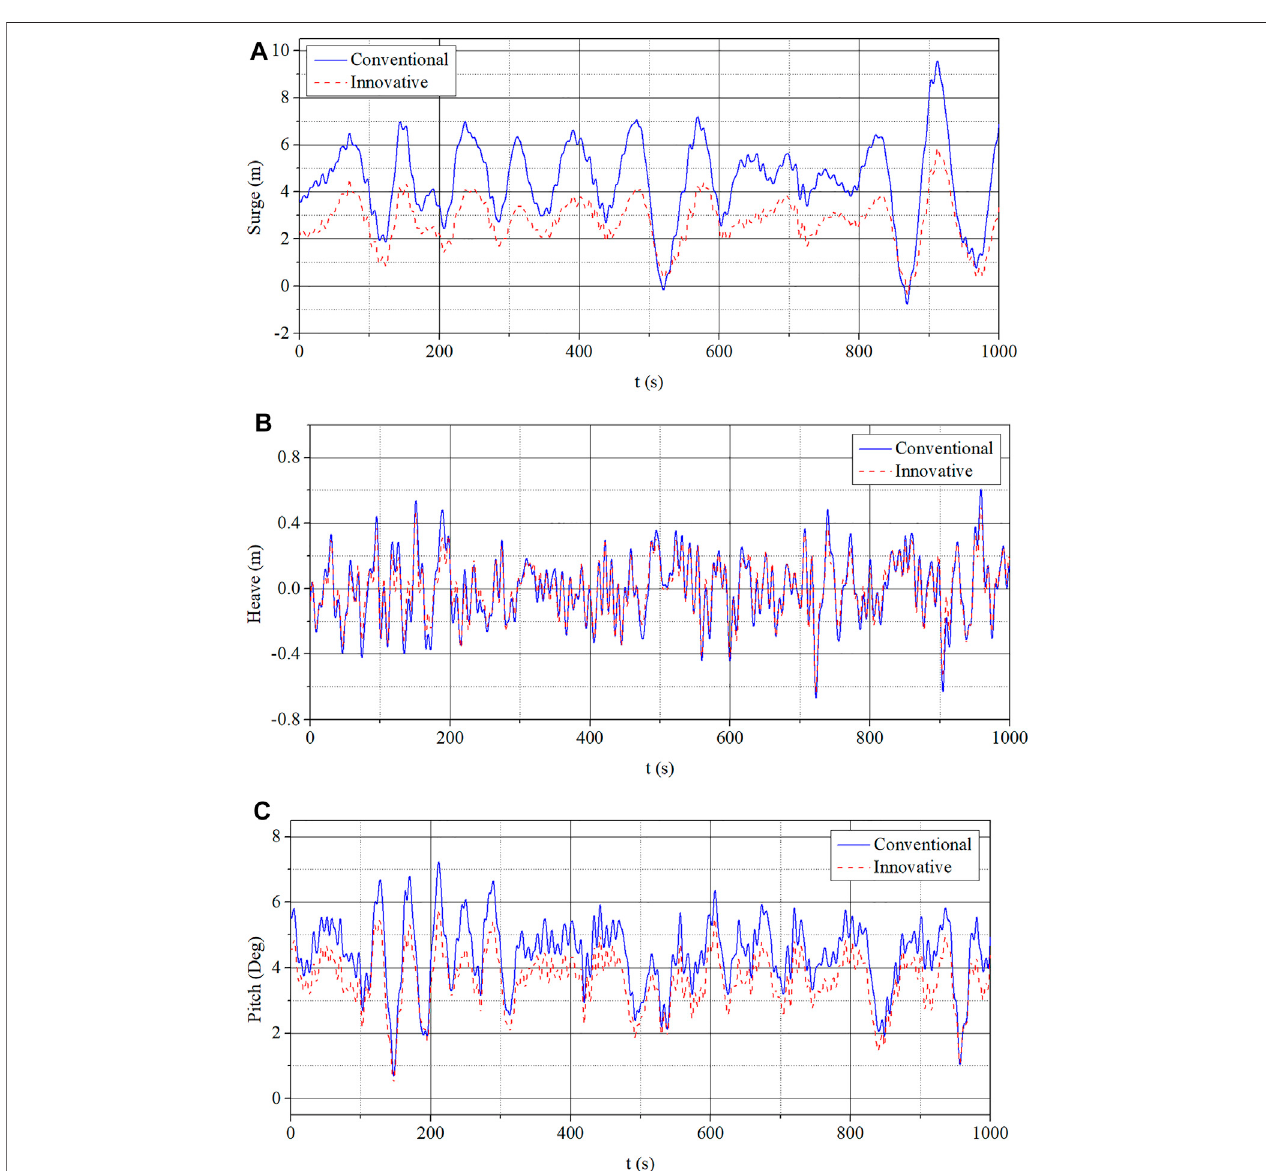
FIGURE 8 | Motion responses. (A) Surge. (B) Heave. (C)